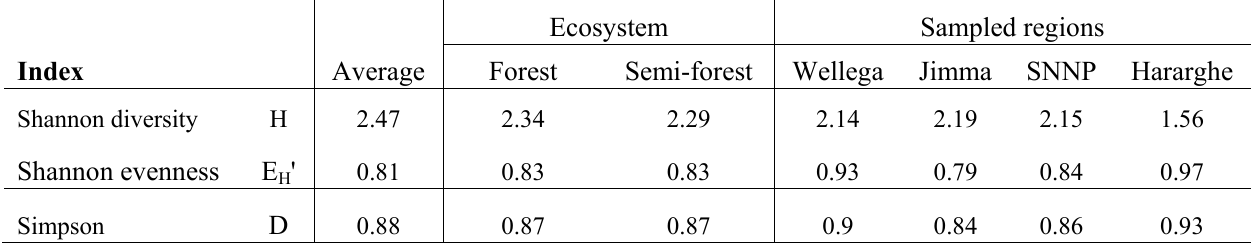
Table 2 . Diversity of Trichoderma in major Ethiopian coffee growing